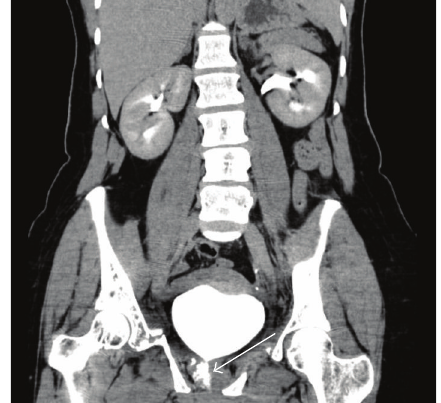
Figure 2: CT scan (early excretory phase) showing leakage of contrast solution from the proximal urethra into the surrounding tissues (white arrow). This typifies a urethral injury with the intact bladder.